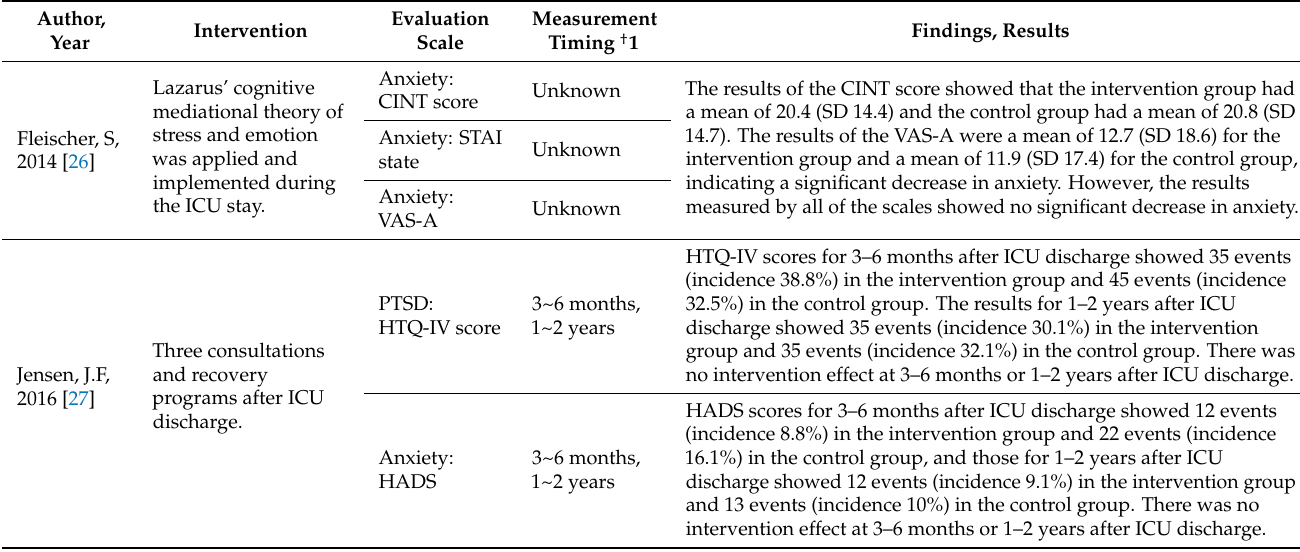
Table 2. Nurse-led interventions and outcomes from